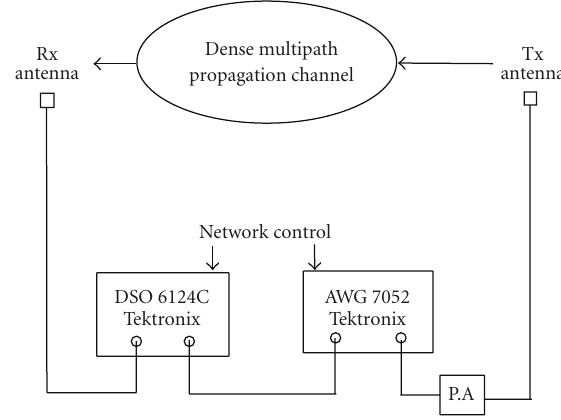
Figure 13: Experimental Setup of the measurement campaign 2.